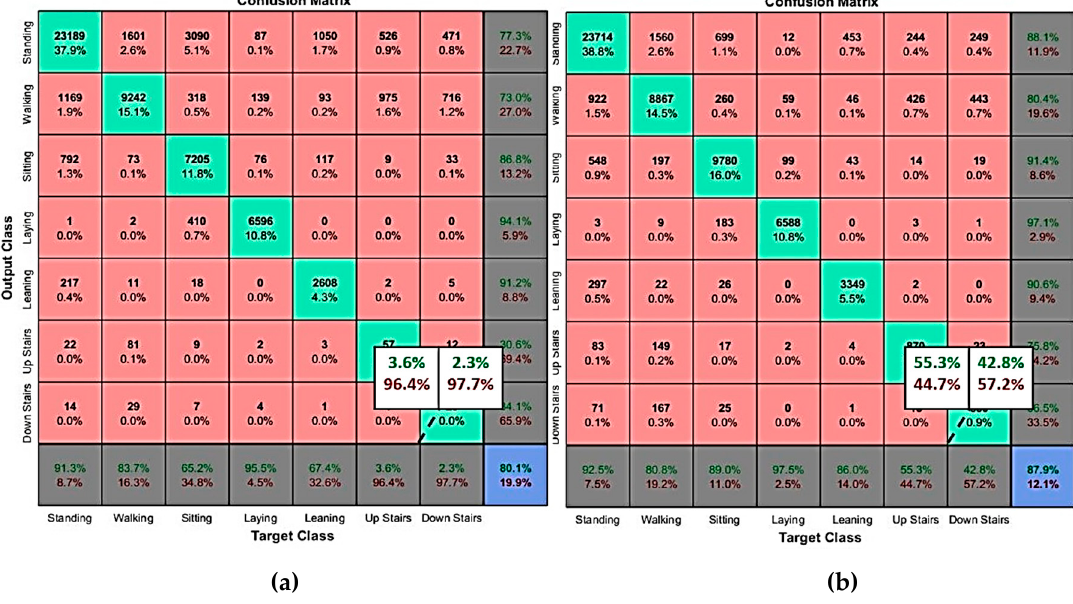
Table 4. Recognition accuracy with raw data, Euler angles, and quaternion in the case of lower back